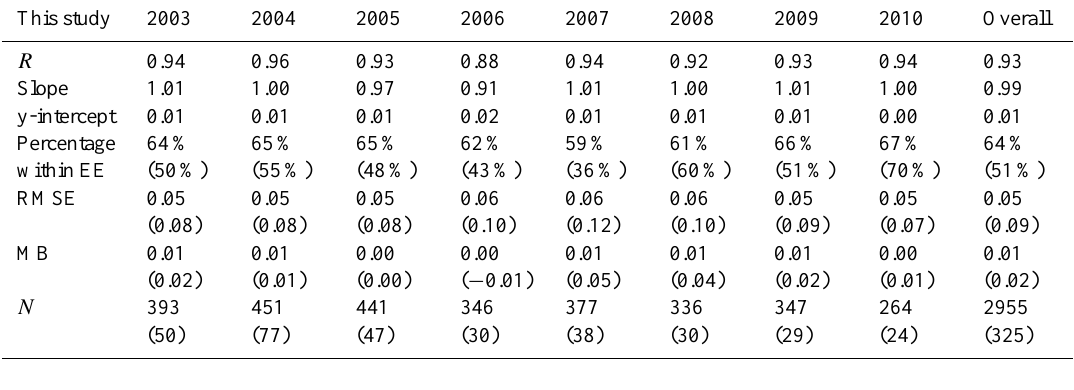
Table 4. Same as in Table 3 except for the test algorithm.